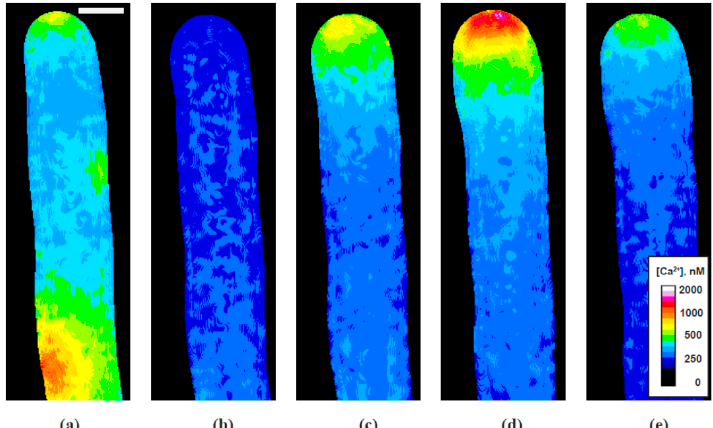
Figure 4. [Ca 2+ ]; Individual frames from a representative time-lapse video illustrating significant spatial distributions of [Ca 2+ ] in a pollen tube transiently exposed to 200 µM KCN: ( a ) calcium “spark” shortly after KCN administration and the start of growth decline; ( b ) minimum cytoplasmic [Ca 2+ ] throughout the cell, corresponding with minimum growth rate; ( c ) initial establishment of the tip Ca 2+ gradient even while growth remains minimal; ( d ) re-established active Ca 2+ gradient during oscillatory growth, showing tip maximum [Ca 2+ ]; ( e ) re-established active Ca 2+ gradient during oscillatory growth, showing [Ca 2+ ] at the tip. Bar in ( a ) corresponds to 10 µm.